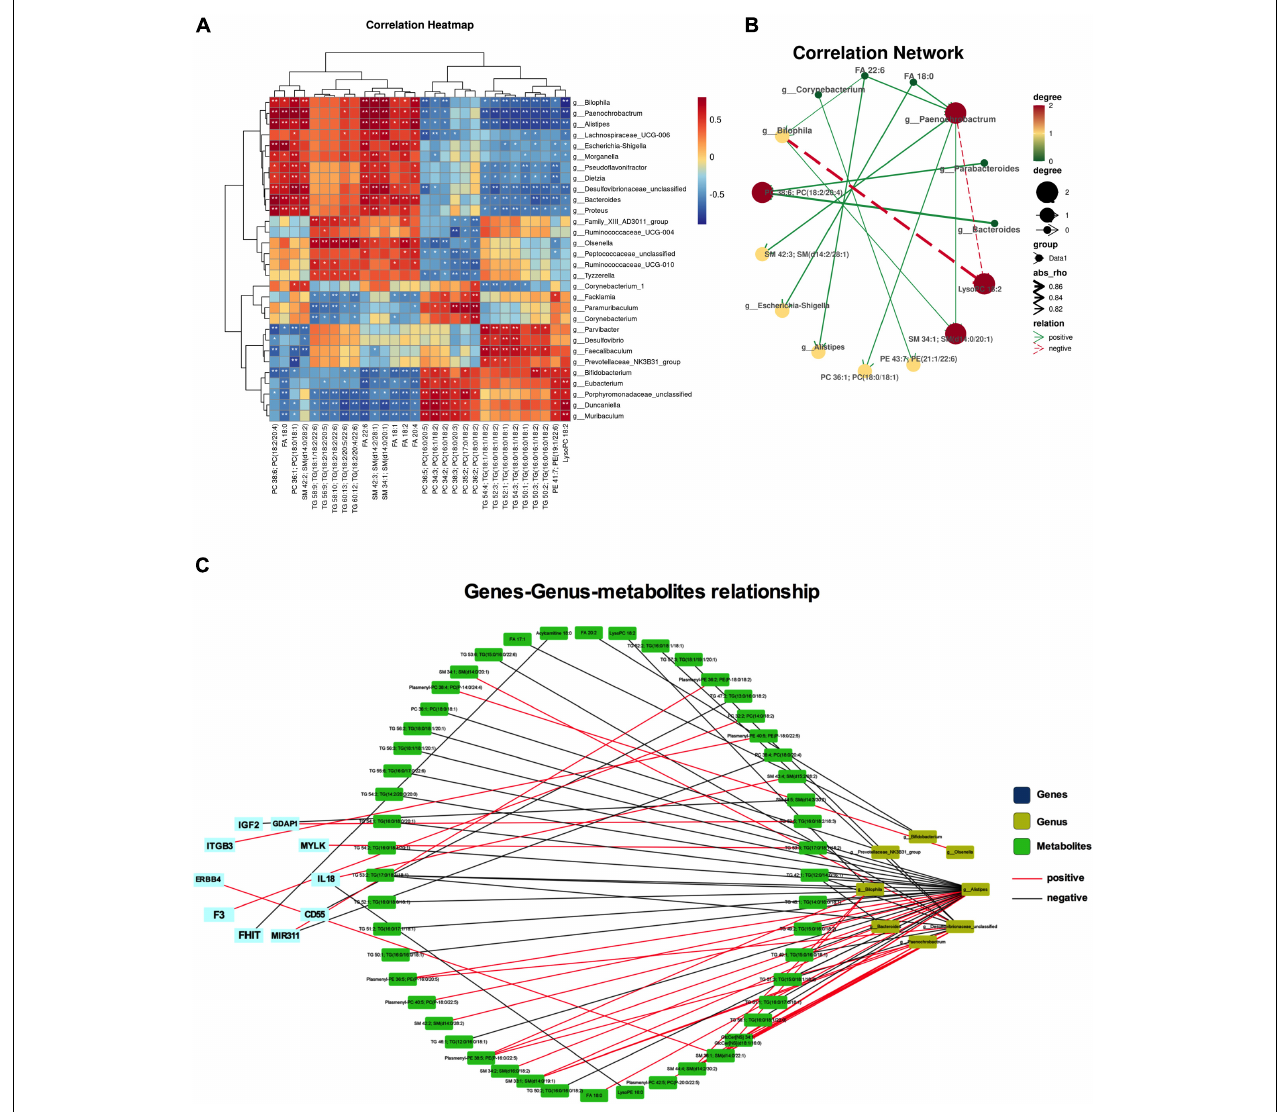
FIGURE 7 | Integrated analyses of metabolites, gut microbiota, and disease genes. Correlation heatmap (* p < 0.05, ** p < 0.01) (A) and correlation network (B) of differential microbiota and metabolites. (C) Correlation network diagram of microbiota, metabolites, and disease gene. Data were calculated by the Pearson correlation method after mean centering and unit variance